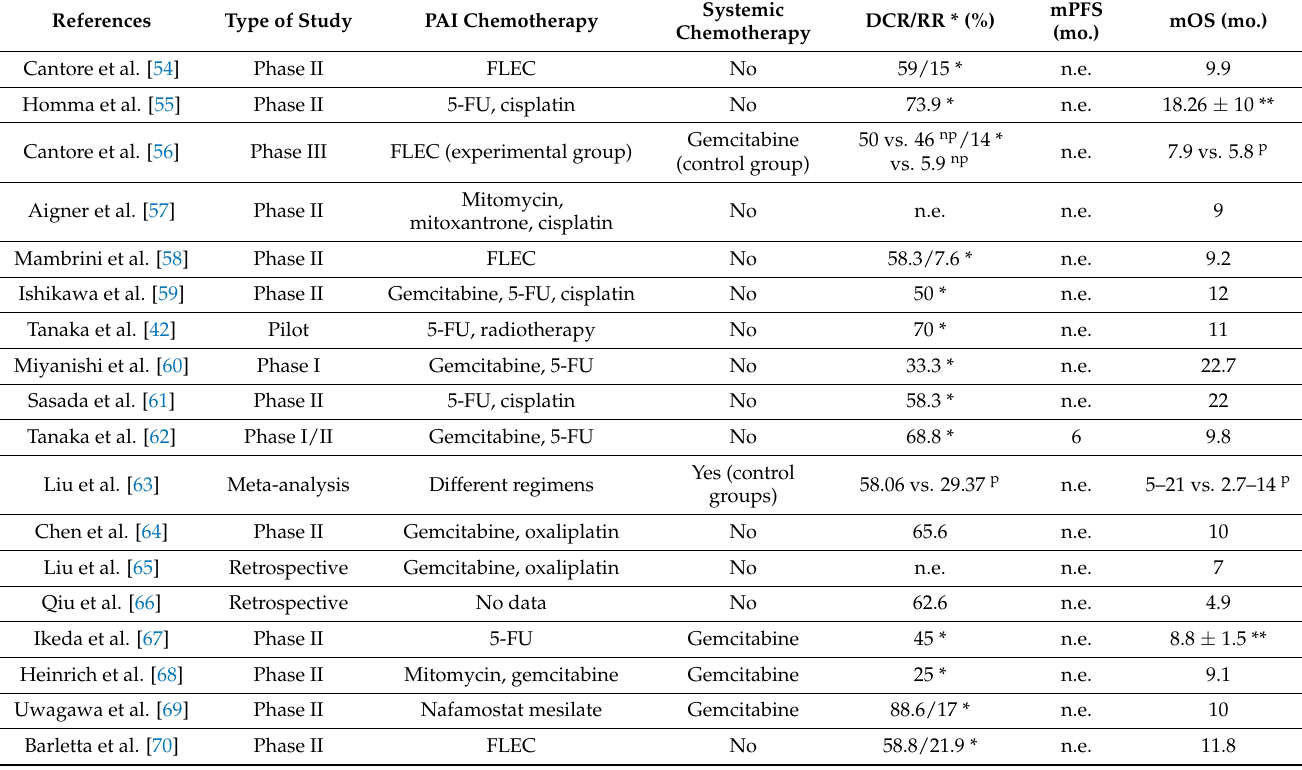
Table 1. Compilation of references included in the review of the literature that evaluated PAI chemotherapy in advanced PC